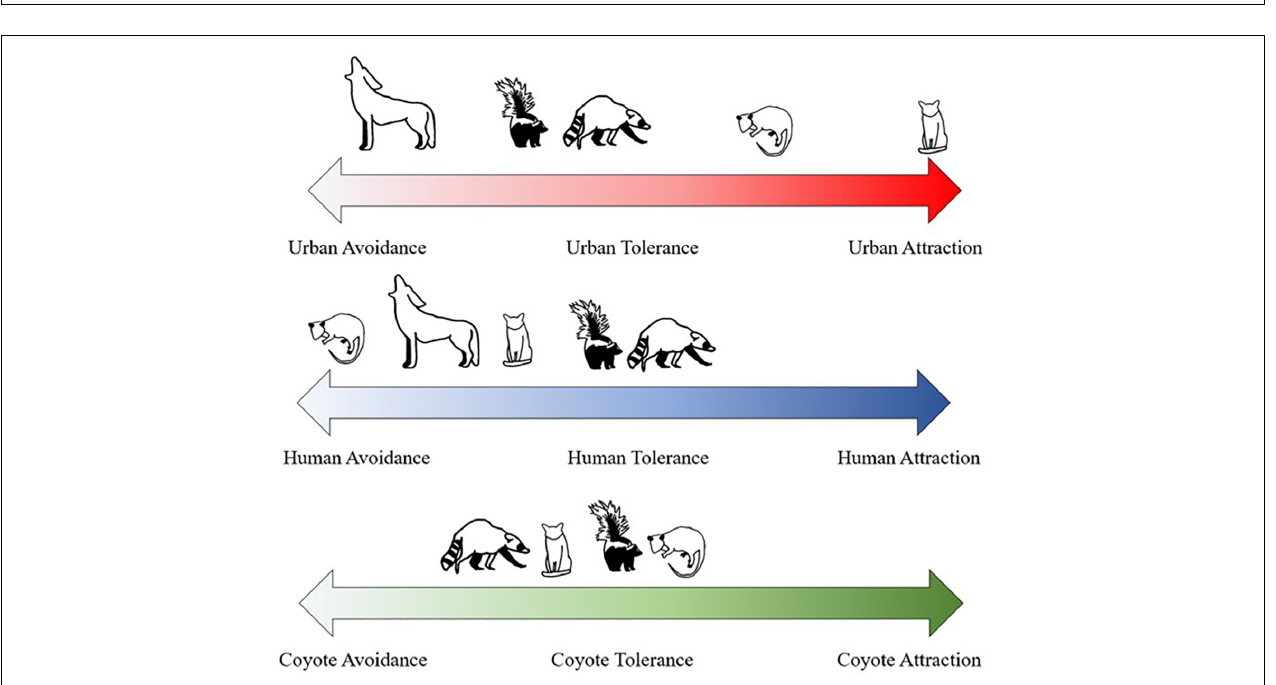
FIGURE 5 | Temporal overlap (Dhat) estimates for (A) coyotes and all subordinate mesopredators and (B) humans and all mesopredators across non-urban, low urban, and high urban intensities. 95% confidence intervals are derived from 10,000 bootstrap analyzes. Dashed line at 0.50 represents a visual marker for temporal overlap estimates where species share at least 50% temporal activity.